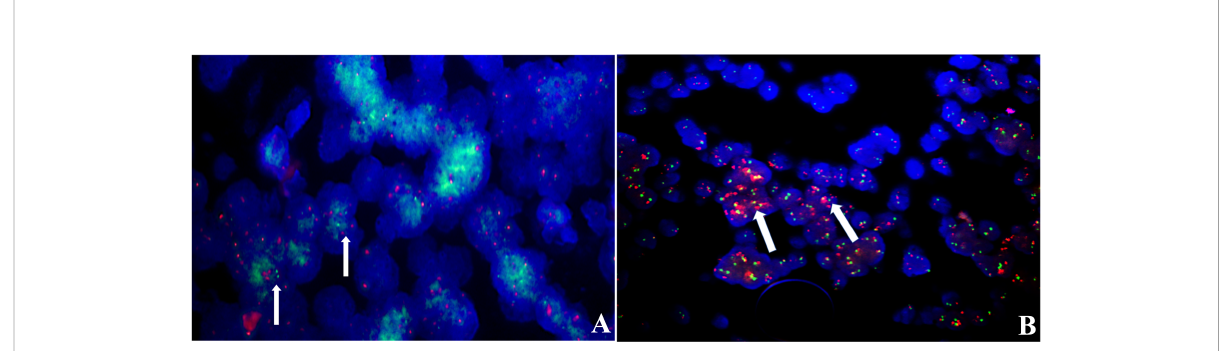
FIGURE 6 FISH analysis, (A) N-MYC for relapsed case 8 showed increased copy numbers, green signals (white arrows); (B) case 12 showed ampli fi cation in the GSP C19MC probe, red signals (white